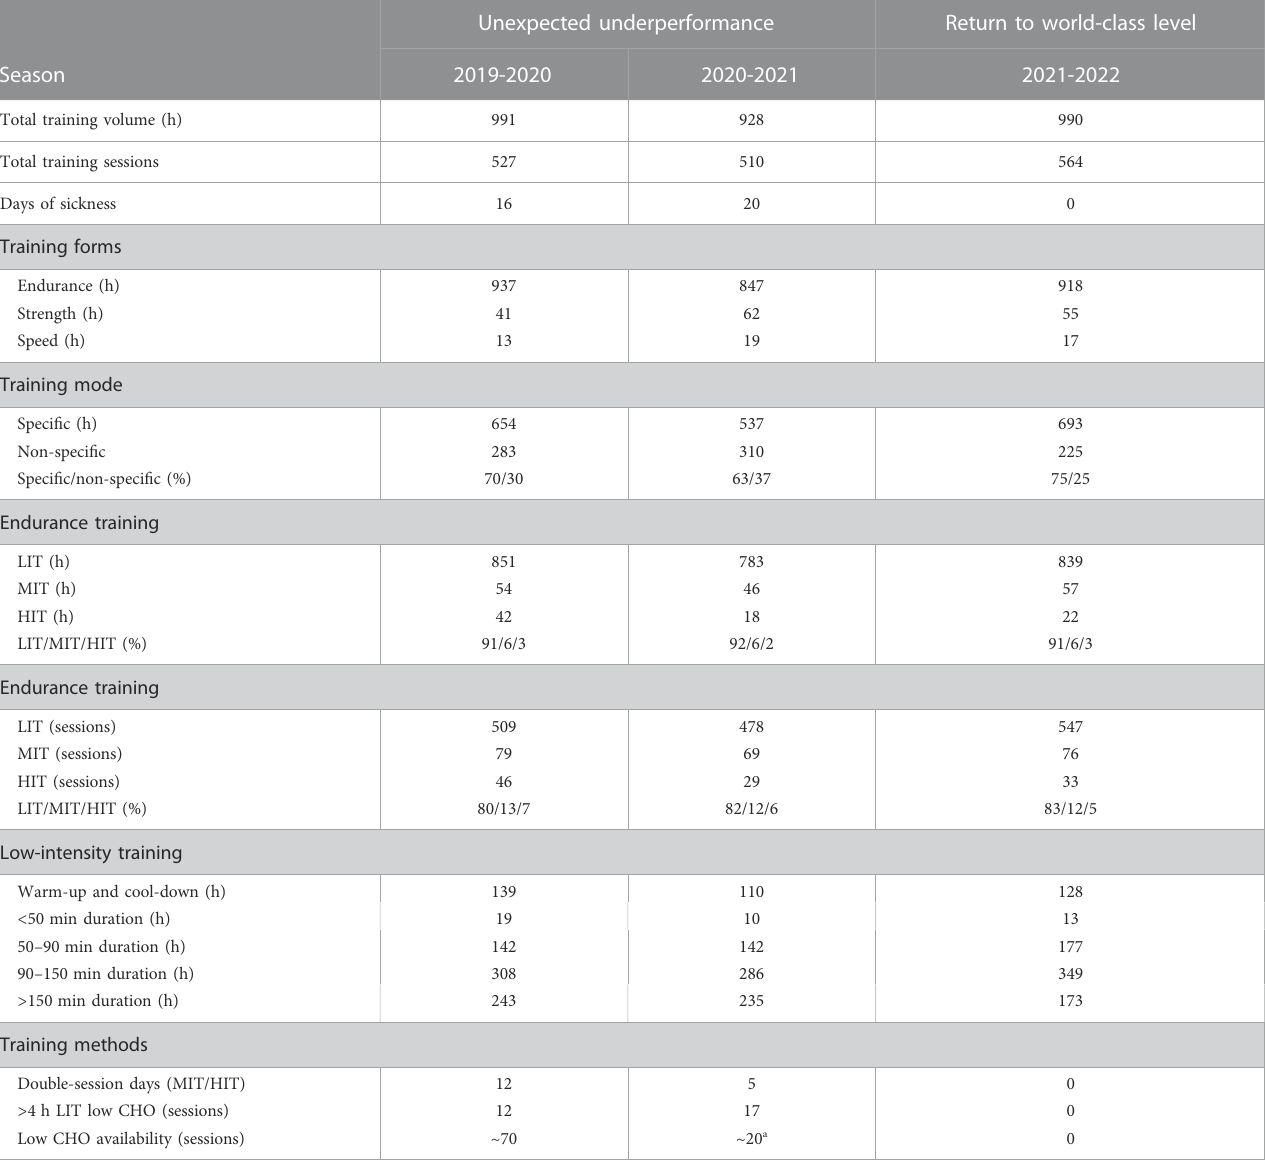
TABLE 2 Annual training data over two seasons of unexpected underperformance and the season returning to world-class level in a male cross-country